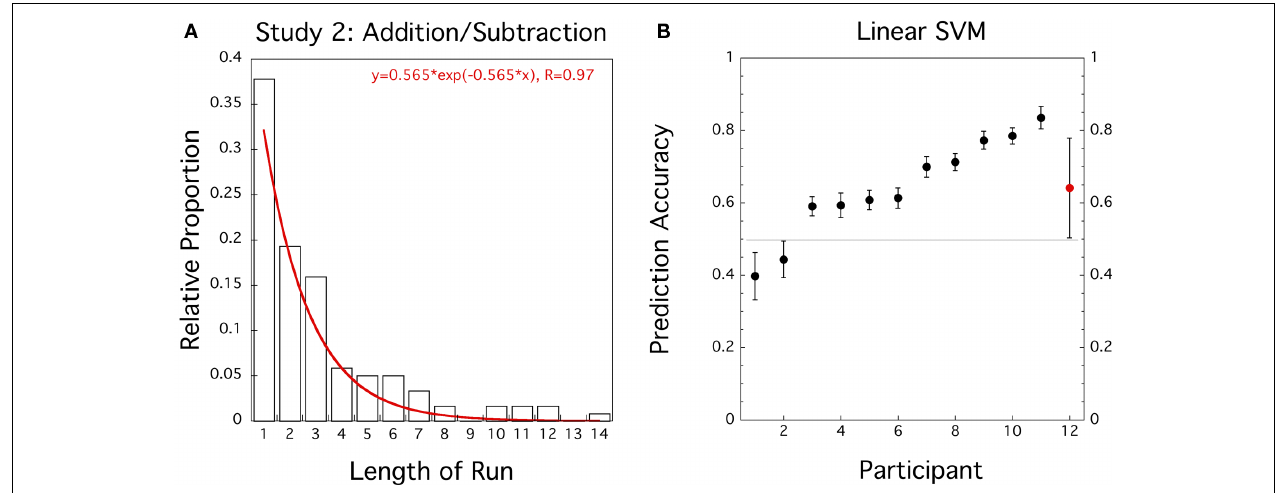
function. (B) Prediction accuracies of linear SVM trained on preceding and current responses for individual data sets (black circles, error bars =± 1 SD bootstrapped) and group average (red circle, error bar =± 1